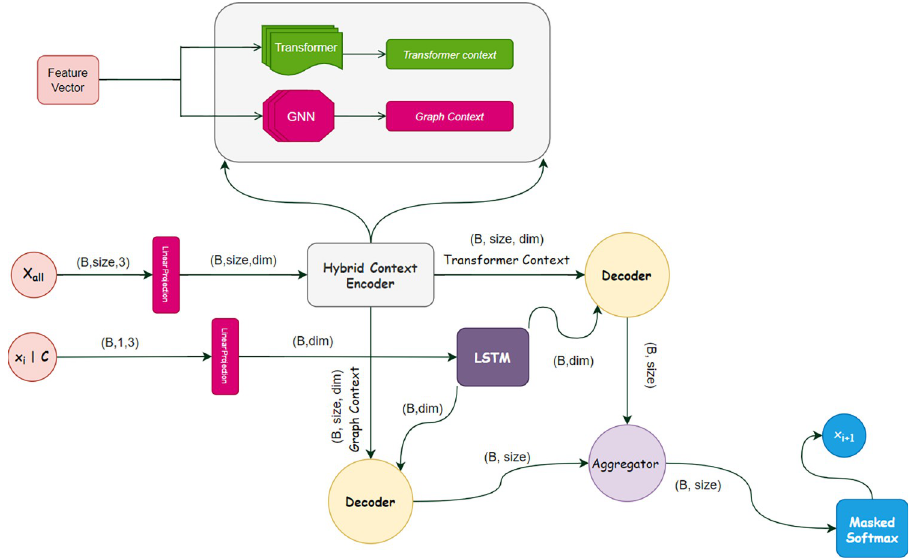
Fig 3. Illustration for how features flow inside HPN. Feature vector consists of thee vectors: two city’s coordinates and the cities’ demand. | means concatenate both currently selected points with the truck’s remaining capacity.